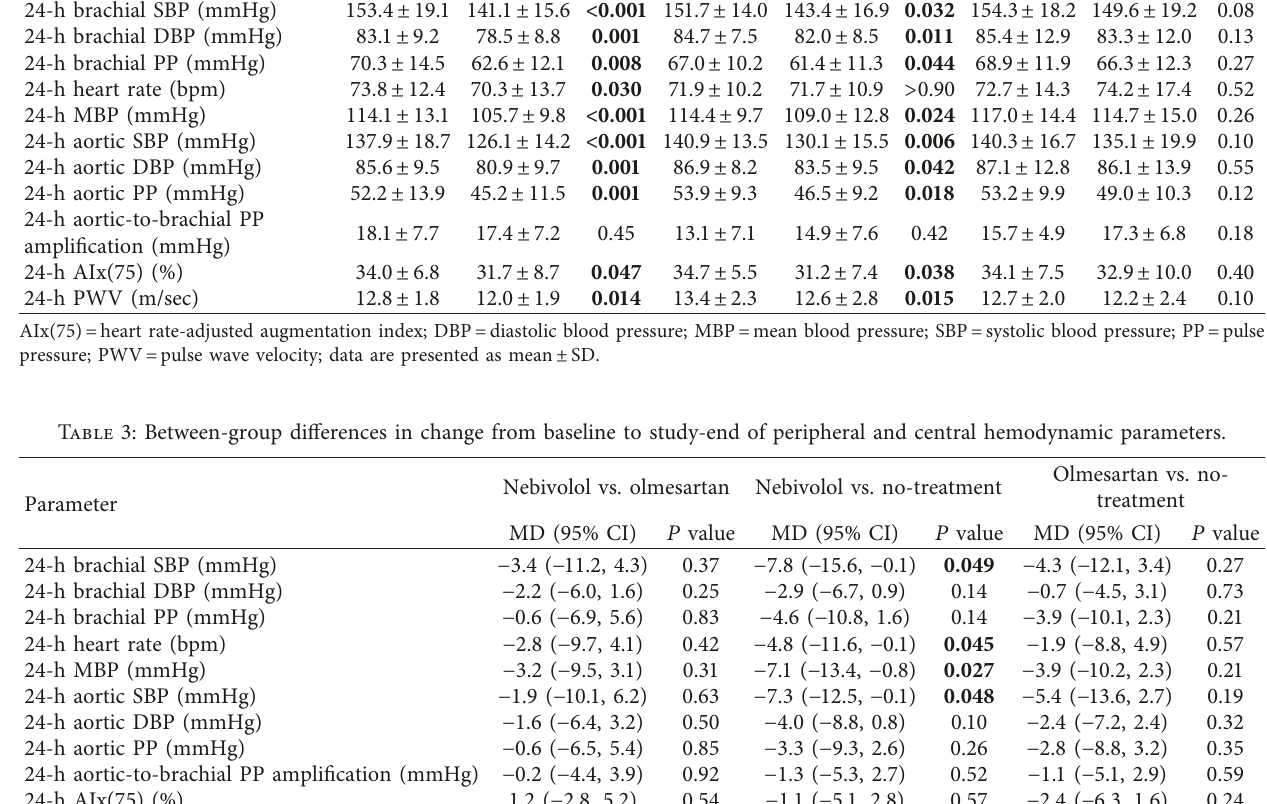
Table 2: Comparisons of peripheral and central hemodynamic parameters between baseline and study-end by treatment group. Parameter